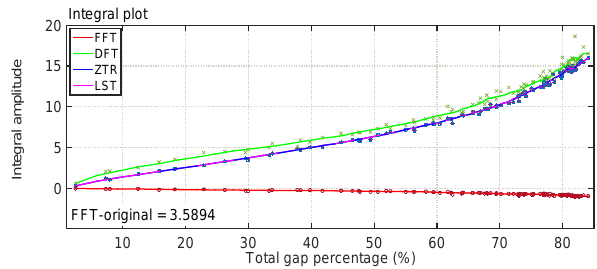
Figure 18. MSG test applied to the VEX data set: integral ampli- tudes as a function of TGP. The format is similar to Fig.